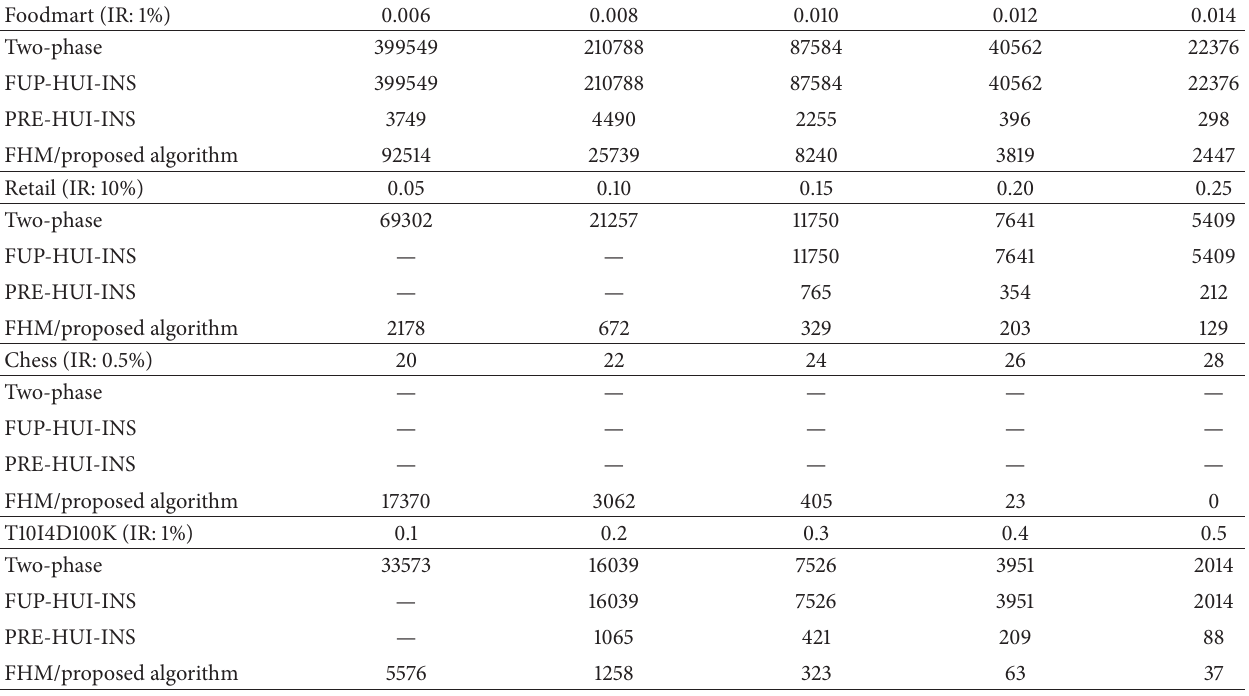
Table 8: Number of candidates and HUIs under various minimum utility